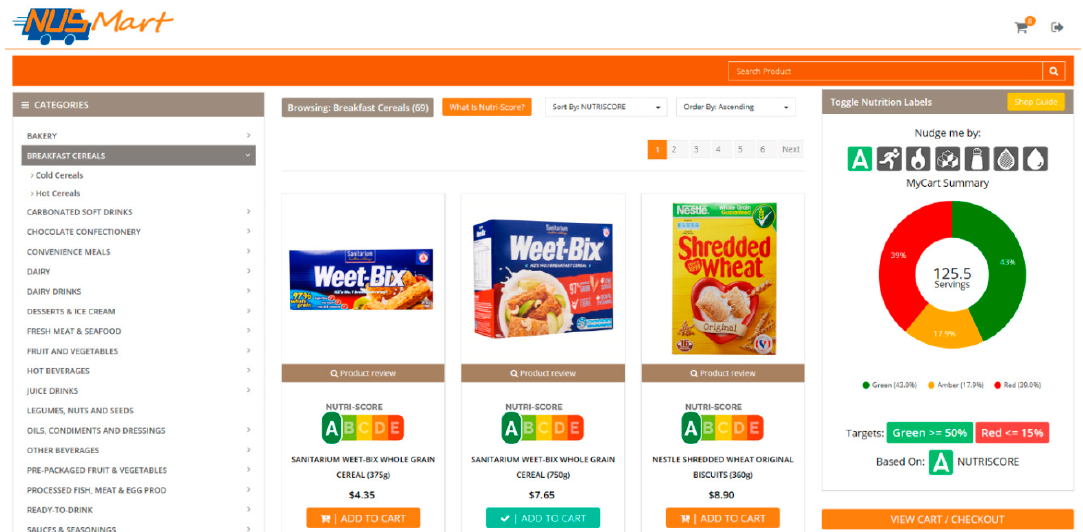
Figure 1. Screenshots of the two versions of the NUSMart webpage: ( A ) control arm and ( B ) dynamic food labels with real-time feedback (DFLF) arm.